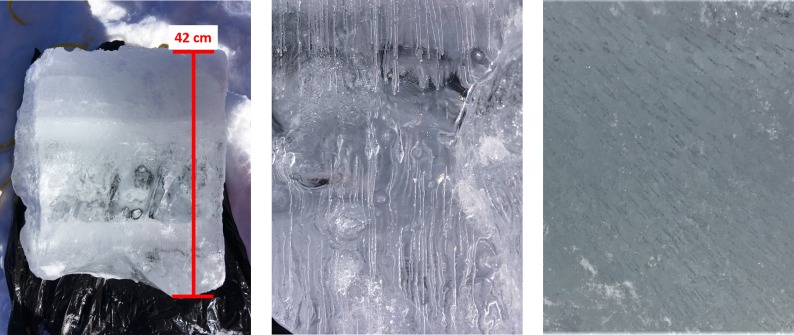
Ice block (42 cm) extracted from MacDonald Lake in Central Ontario.The stratification of the ice layer with top forming white ice (snow ice) and bottom growing clear ice is visible (left) with tubular bubbles present (centre) and zoom in on the bottom surface (right).